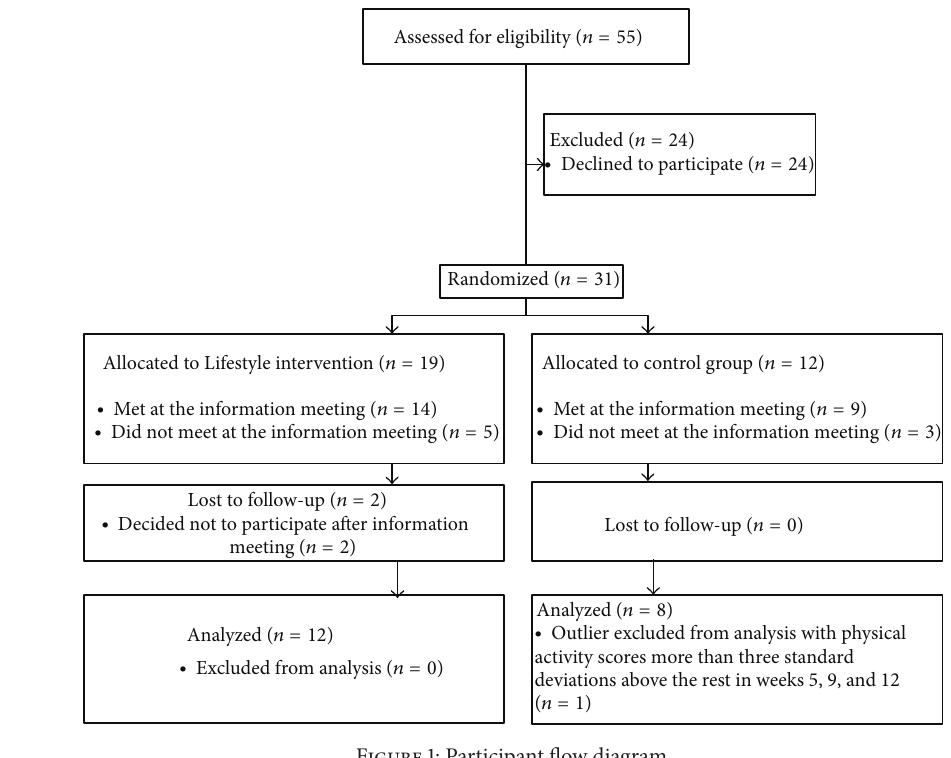
Figure 1: Participant flow diagram.